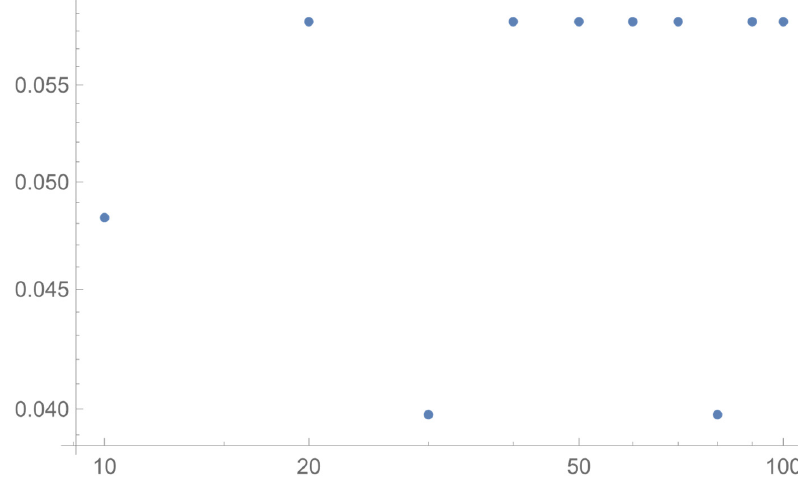
Figure 7. IPOPT performance on standard LSP model-instances, with random starting solutions up to 𝑛 = 100. Difference between the area 𝐴(𝑛) of the optimized polygon and 𝜋 4⁄ . 4. 𝑳𝑺𝑷 ( 𝒏 ) Regression Model for Even 𝒏